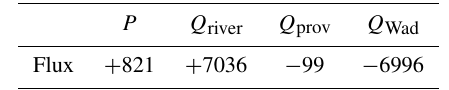
Table 2. Average annual inputs and outputs for the Lake IJssel region in millimetres. Values are obtained from operational LHM model simulations. Note that Q river can be much smaller during dry summer